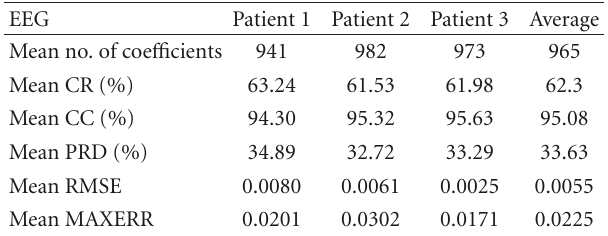
Table 4: Performance of our method on the 3 EEG